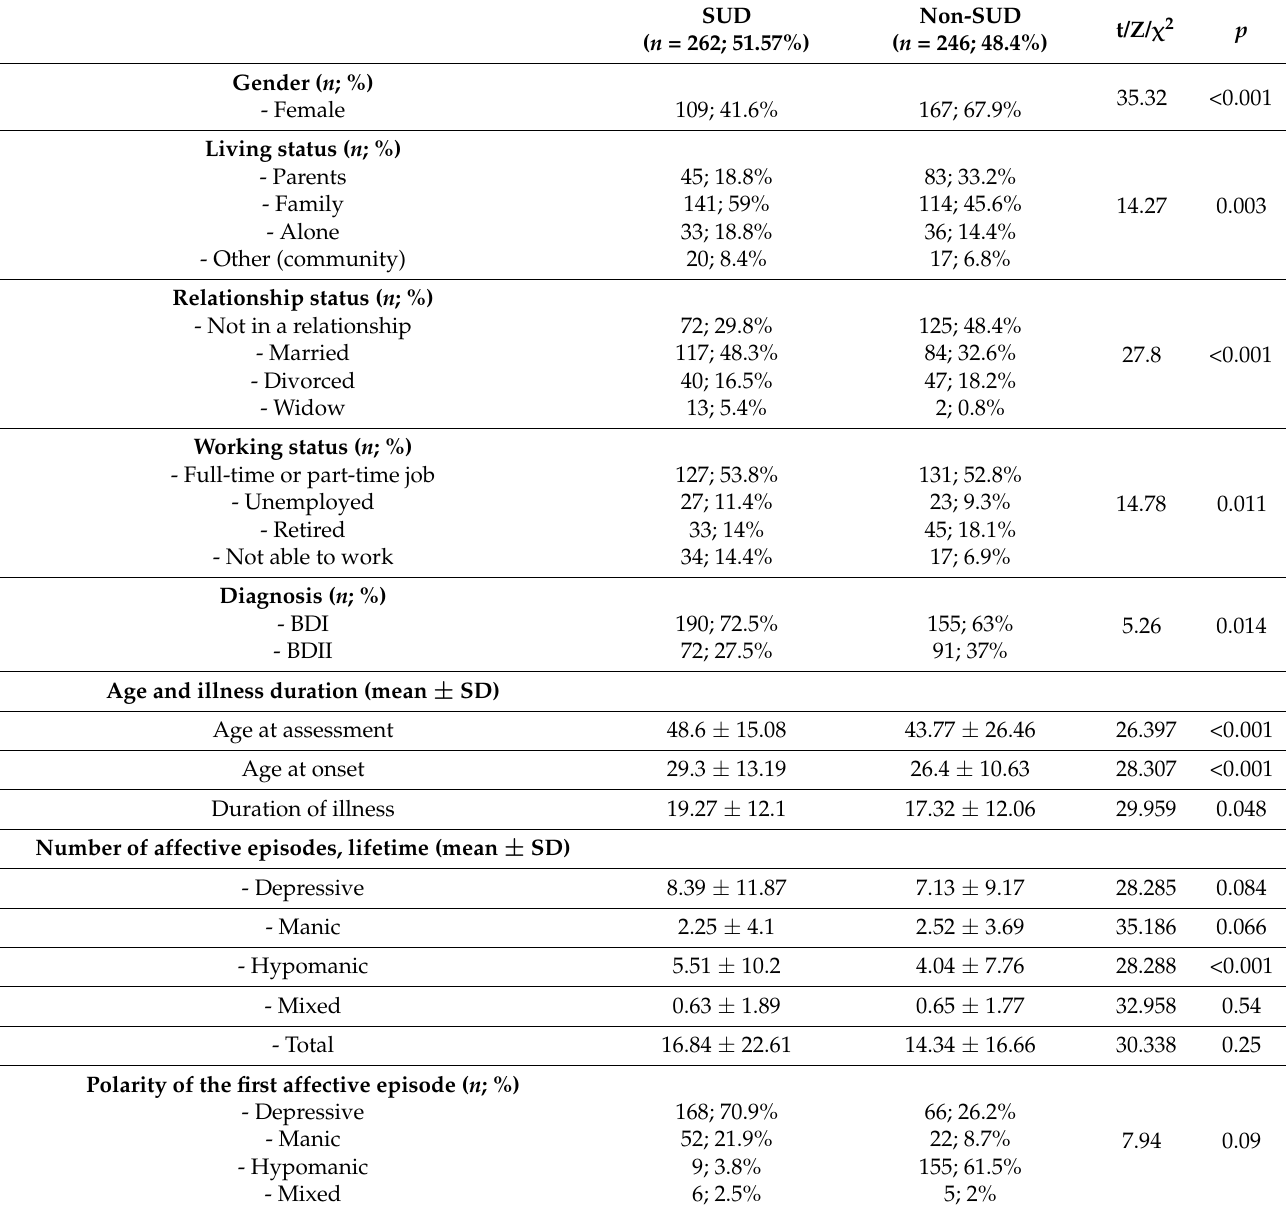
Table 1. Socio-demographic and clinical characteristics of the sample classified according to the presence of substance use